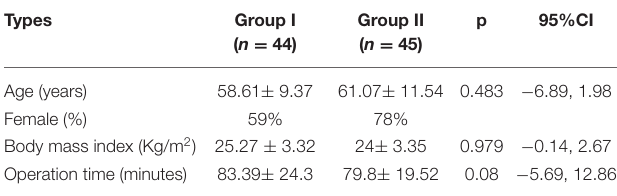
TABLE 1 | Baseline table of